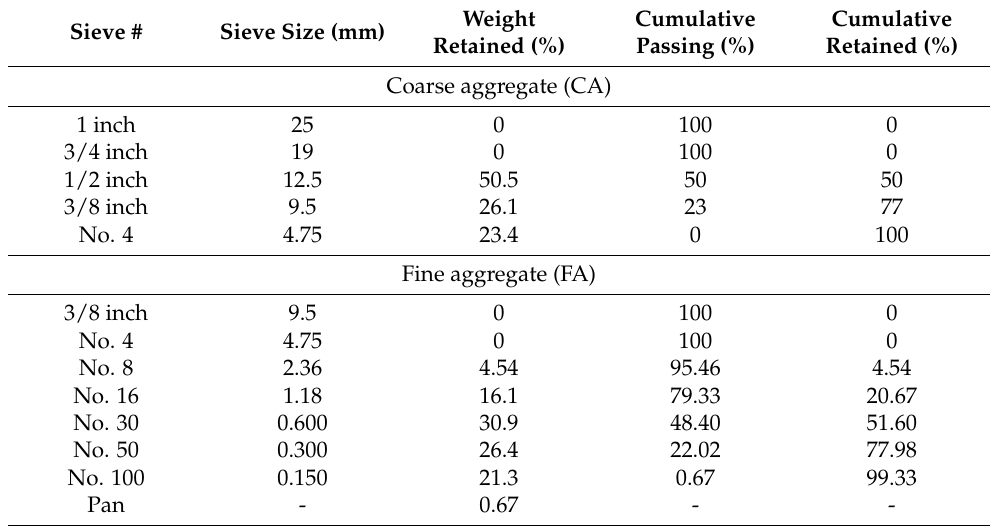
Table 2. Sieve analysis of aggregates (ASTM